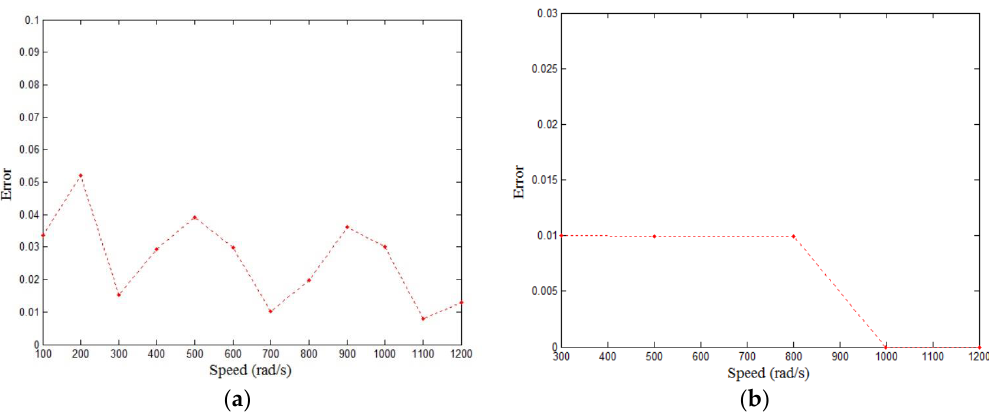
Figure 15. ( a ) The error level of the simulation results of back electromotive force; ( b ) The error level of the simulation results of torque.